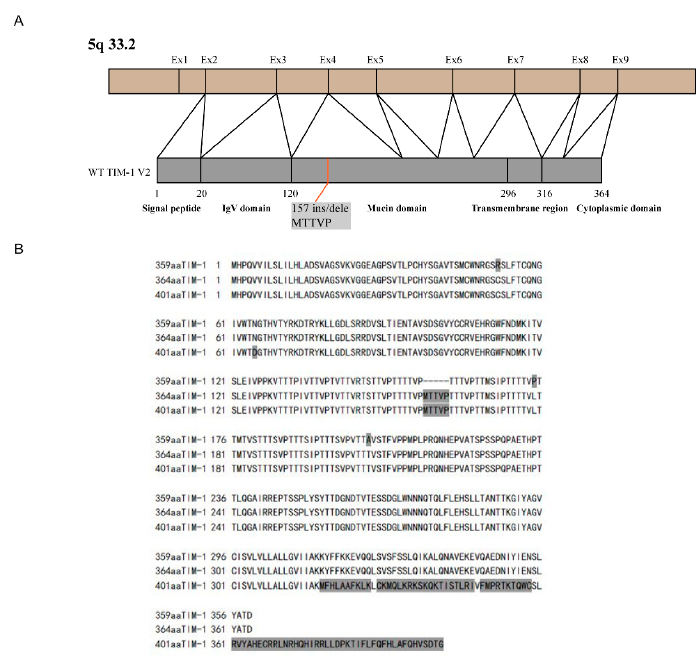
Figure 2. Human TIM-1 amino acid sequence and structural domains. ( A ) TIM-1 gene localization, and construction of TIM-1 protein functional domain; ( B ) amino acid sequence of the three TIM-1 variants with their differences indicated in gray.